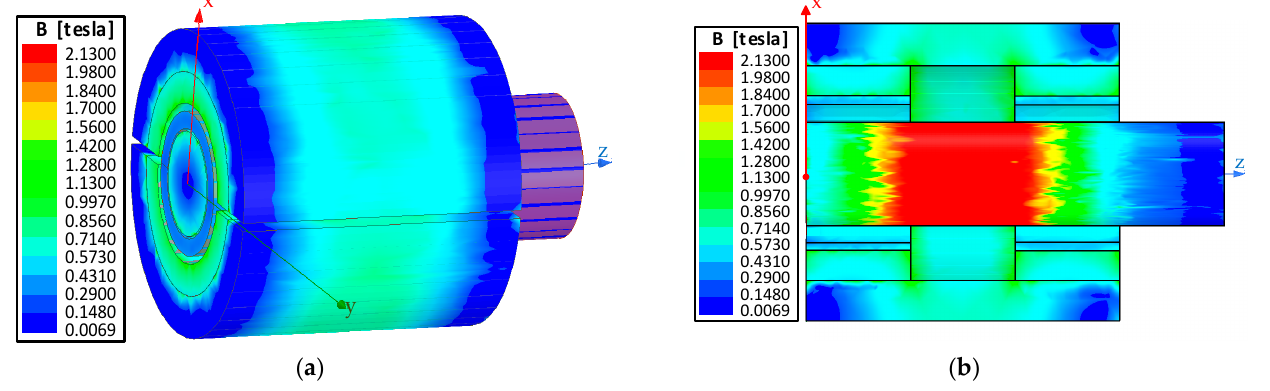
Figure 8. Magnetic flux vector density of the CDCLM. ( a ) full view; ( b ) cross-sectional view. As shown in Figure 8, while color changes from blue to red, the magnetic flux density increases. The highest magnetic flux density is 2.13 T while the lowest magnetic flux density is 6.9 mT. The highest magnetic flux density is shown on the core with red color. The reason for this is that the magnetic fluxes of two symmetrical magnetic circuits complete their circuits in the same direction through the core as shown in Figure 5. Compared to the core, the magnetic flux density passing through the right and left yoke is less. However, the magnetic flux density is less in the areas that are not in the magnetic field, such as fifth winding shown in Figure